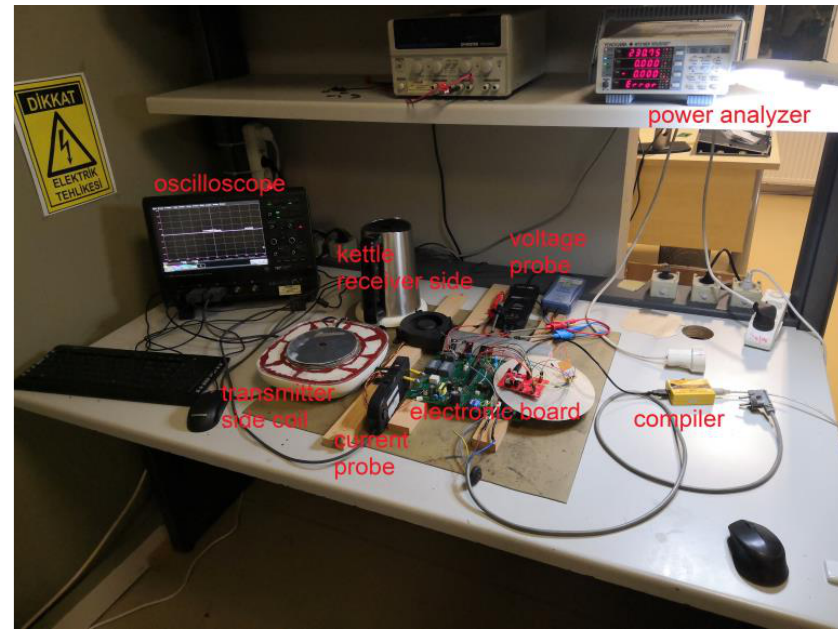
Figure 19. Experimental test setup of WPT system with electric kettle.